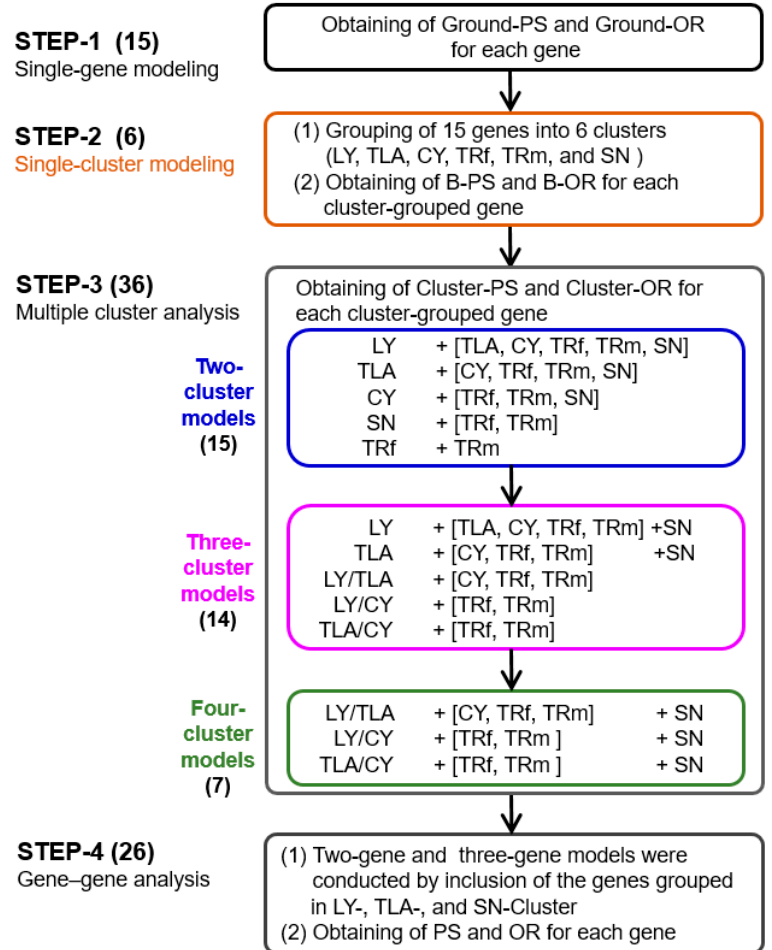
Figure 1. Analysis procedure for cluster–gene and gene–gene interactions. Four major steps were performed, as described in detail in the Section 2. The total number of constructed models for corresponding steps or substeps is indicated in parentheses. Abbreviations: PS, percent of significance; OR, odds ratio; Ground-PS, PS for single-gene model; Ground-OR, OR for single-gene model; B-PS, basal cluster-PS or PS for single-cluster model; B-OR, basal cluster-OR or OR for single-cluster model. (2) Six single-cluster models were constructed to obtain basal cluster-PS (B-PS)